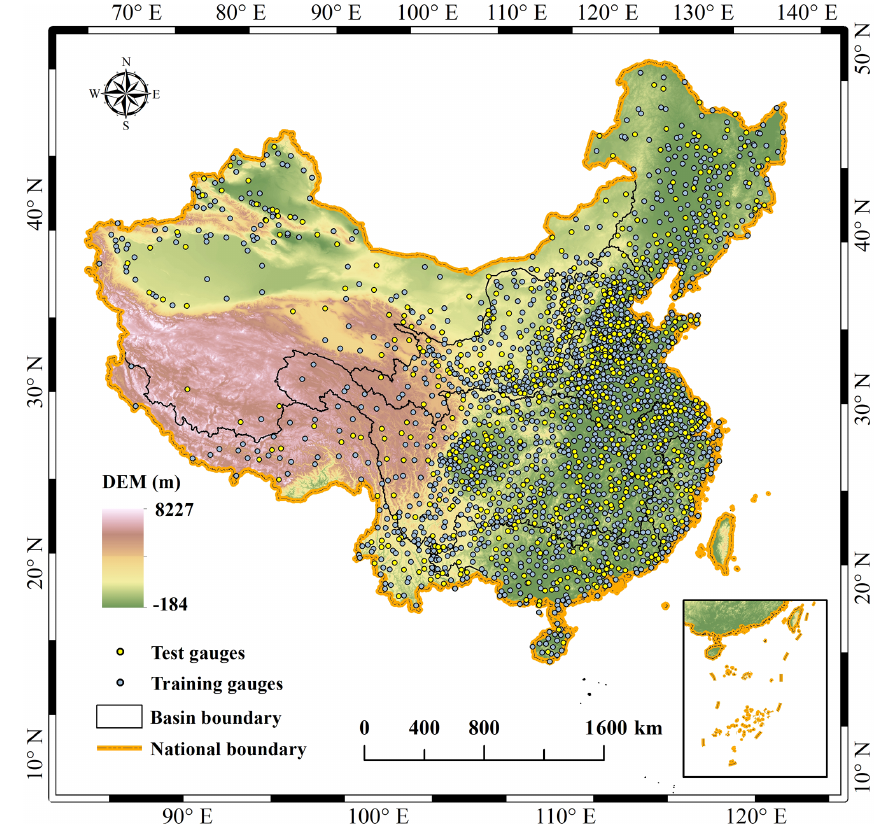
Figure 1. The topography of China and distribution of rain